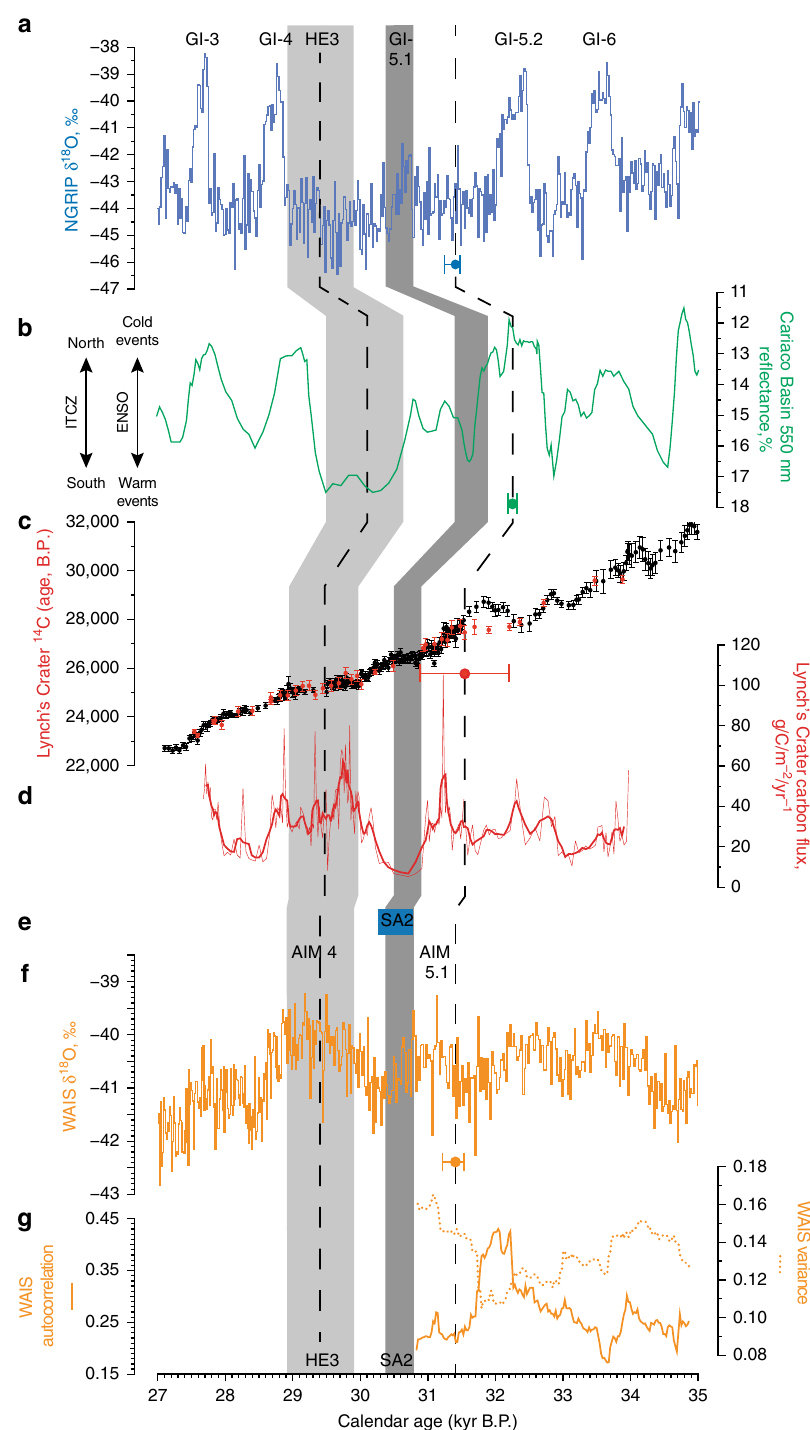
Fig. 2 Global radiocarbon and environmental changes between 35 and 27 kyr BP. Comparison between North Greenland δ 18 O on the GICC05 timescale a 16 , Cariaco Basin greenscale on the modelled Hulu Cave timescale b 14, 33 , Bayesian wiggle-match of the Lynch ’ s Crater ( red ) against the kauri-Lake Suigetsu calibration timescale ( black ) 10 ; 14 C data sets with 1 σ uncertainties (68% con fi dence limits) c , Lynch ’ s Crater carbon fl ux ( red line : 5-point running mean) d ; the climatostratigraphic placement of South Atlantic ice rafted debris layer 2 (SA2) 21 e ; and the West Antarctic Ice Sheet Divide (WAIS) δ 18 O (ref. 6 ) on the WD2014 sync (synchronized to GICC05) timescale (see Methods) f with calculated autocorrelation and variance values g . Greenland interstadials (GI) are numbered above the NGRIP δ 18 O record ( a ). The positions of Heinrich Event 3 (HE3), Greenland Interstadial 5.1 (GI-5.1) and SA2 in each record are shown as grey columns . The dashed lines denote the time range captured by the 2000-year kauri 14 C record used in this study 10 . Calendar age uncertainties for synchronization of records shown at 2